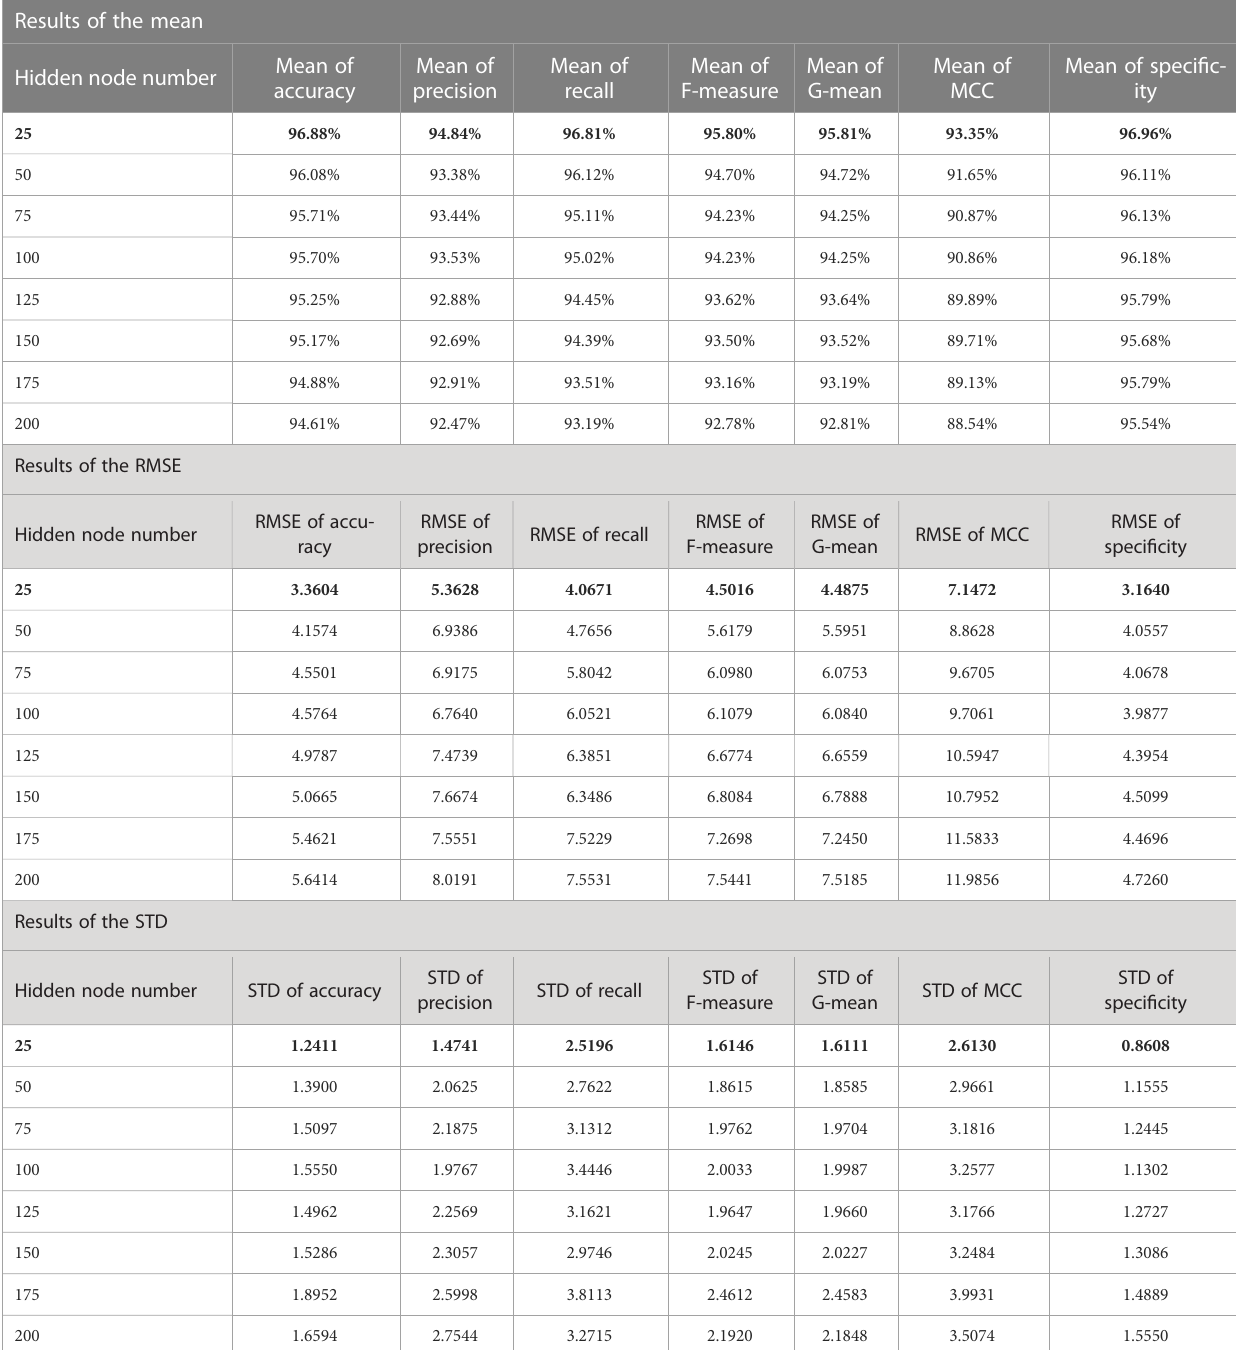
TABLE 7 The statistical results for all experiments of the proposed FLN algorithm using the WDBC